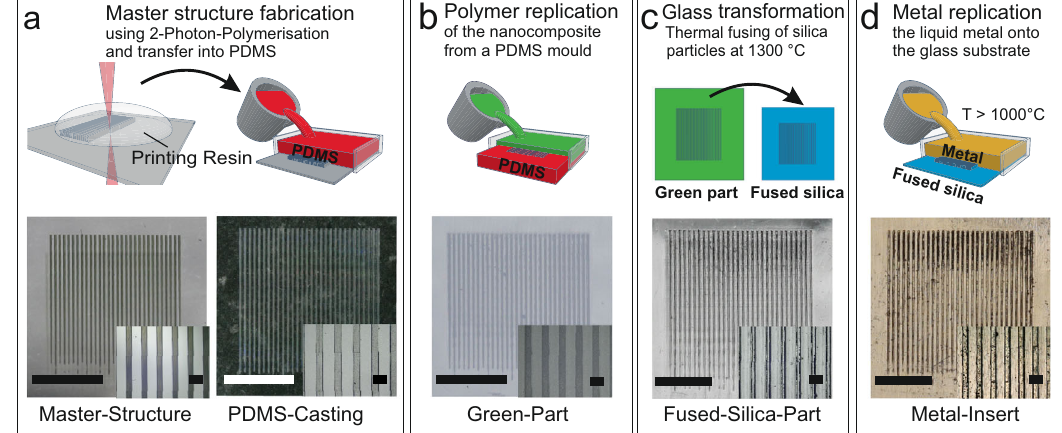
Fig.1|Processfromthemasterstructuretothemetalreplication.a Themaster (positive) structure is fabricated using 2-photon-polymerisation before being copied into polydimethylsiloxane (PDMS) via casting (negative) (scale bar: 5mm, magni fi ed view scale bar: 500 µ m). b Fused silica part (positive) fabrication, by castingsilicananocompositeontothecreatedPDMS-Replicationmouldandcuring